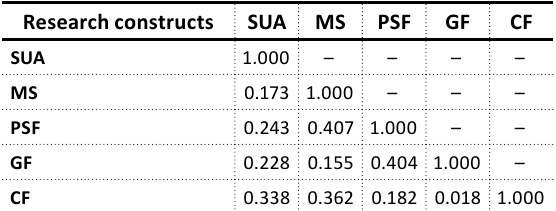
Table 2. Correlation between the